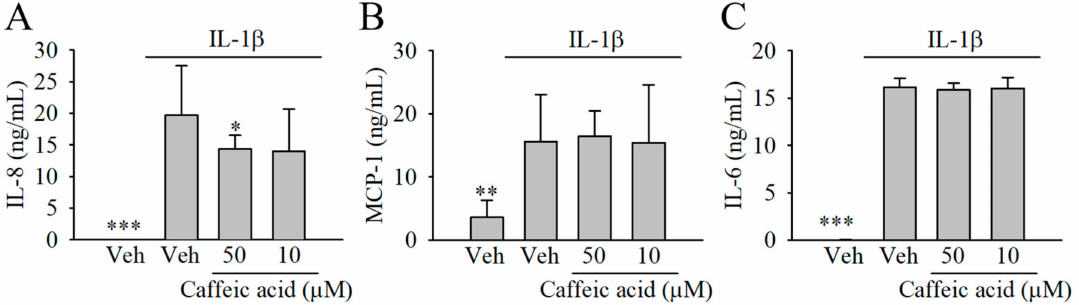
Figure 4. Effect of caffeic acid on the biosynthesis of ( A ) IL-8, ( B ) monocyte chemoattractant protein-1 (MCP-1), and ( C ) IL-6 in IL-1 β -stimulated myofibroblasts of the colon, CCD-18Co. In the absence of caffeic acid, the cells were treated with 0.5% ( v / v ) DMSO in the presence or absence of IL-1 β (inflamed or control cells, respectively). The bar graph shows the data as the average ± standard deviation (SD) of three independent experiments ( n = 3). Each treatment was performed in triplicate. Significant differences are indicated in the figures as follows: * p < 0.05, ** p < 0.01, and *** p <